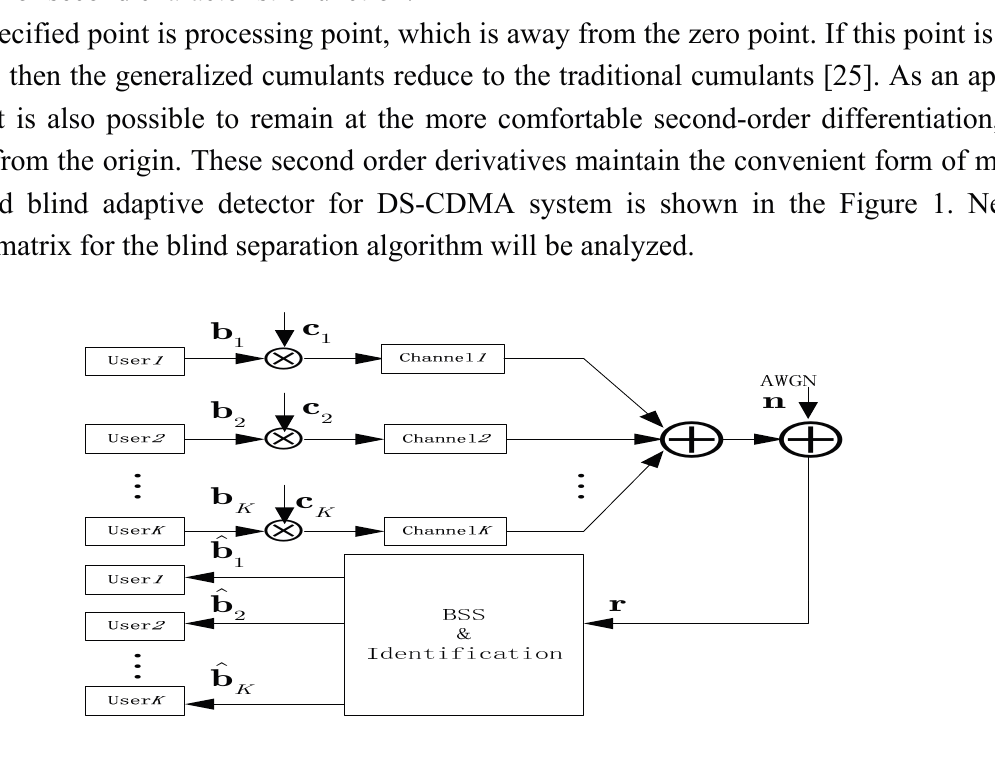
Figure 1. Blind adaptive detector based DS-CDMA